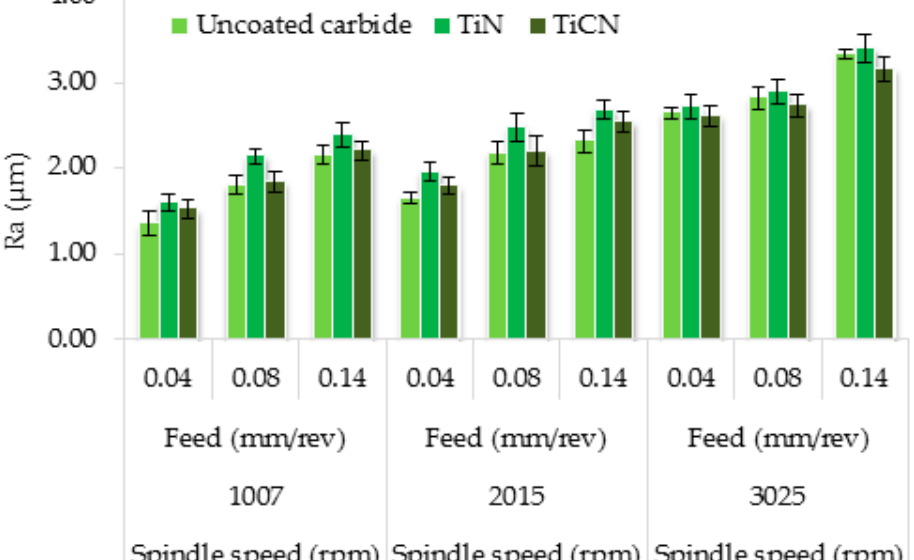
Figure 6. Average surface roughness (µm).